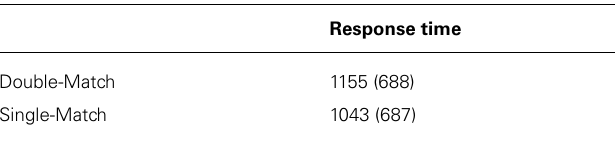
Table 2 | Mean response times (and standard deviation) for correctly answered